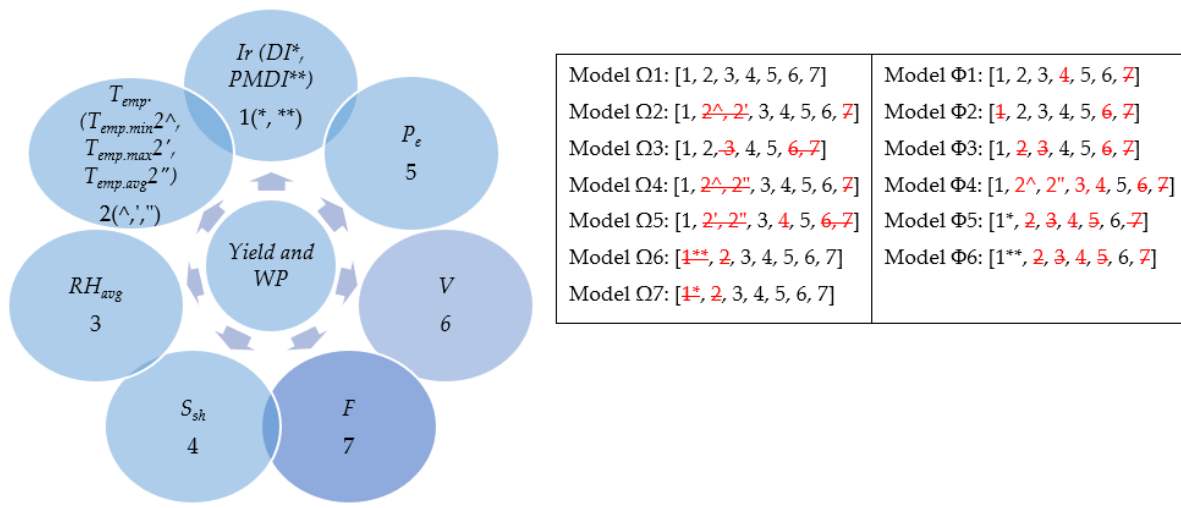
Figure 5. Combinations of input parameters to estimated yield and WP. * Drip irrigation, ** Drip irrigation with plastic mulch, ^ Minimum temperature, ' Maximum temperature, " Average temperature.